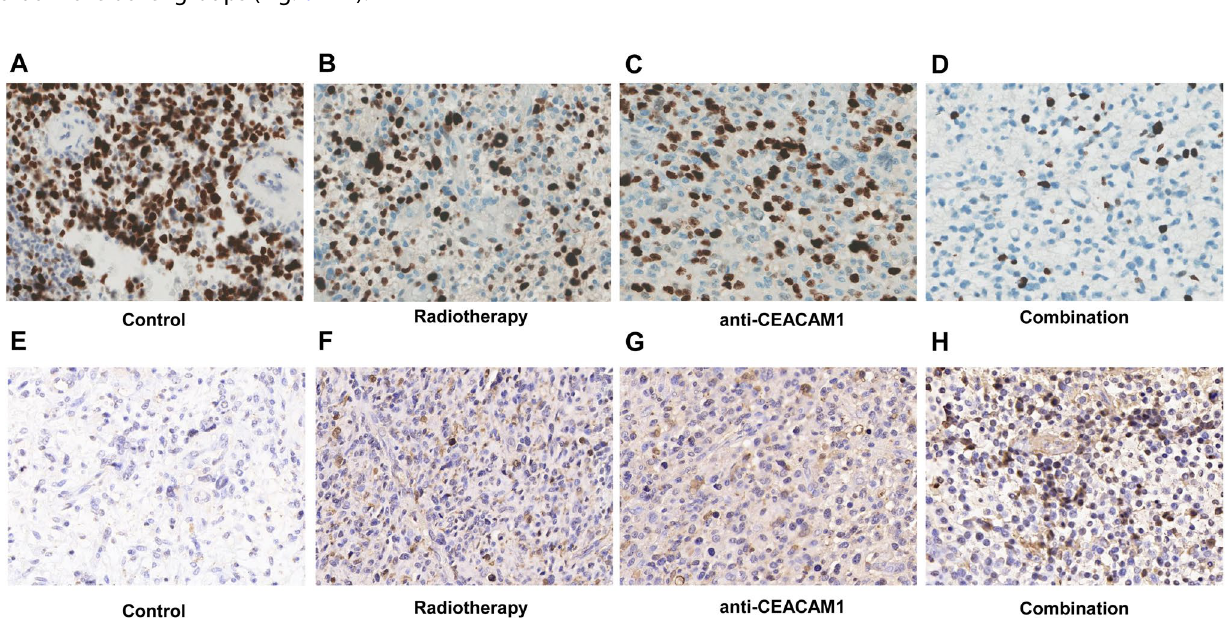
Fig. 6 Ki-67 and TUNEL for proliferation and apoptosis in the tumor tissues in different groups detected byimmunohistochemistry. A – D Expression of Ki-67 in the glioma tissues of mice in different groups. E – H Theapoptosis of tumor tissues in different